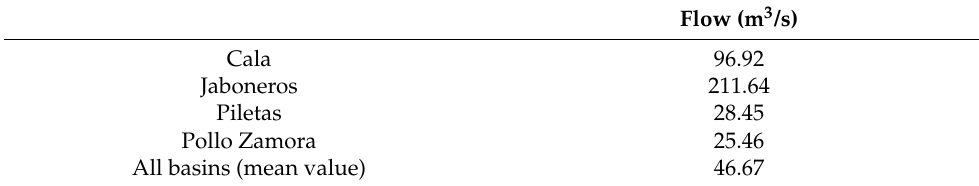
Table 3. Maximum instantaneous flow in the study areas according to the rational method modified by T é mez.